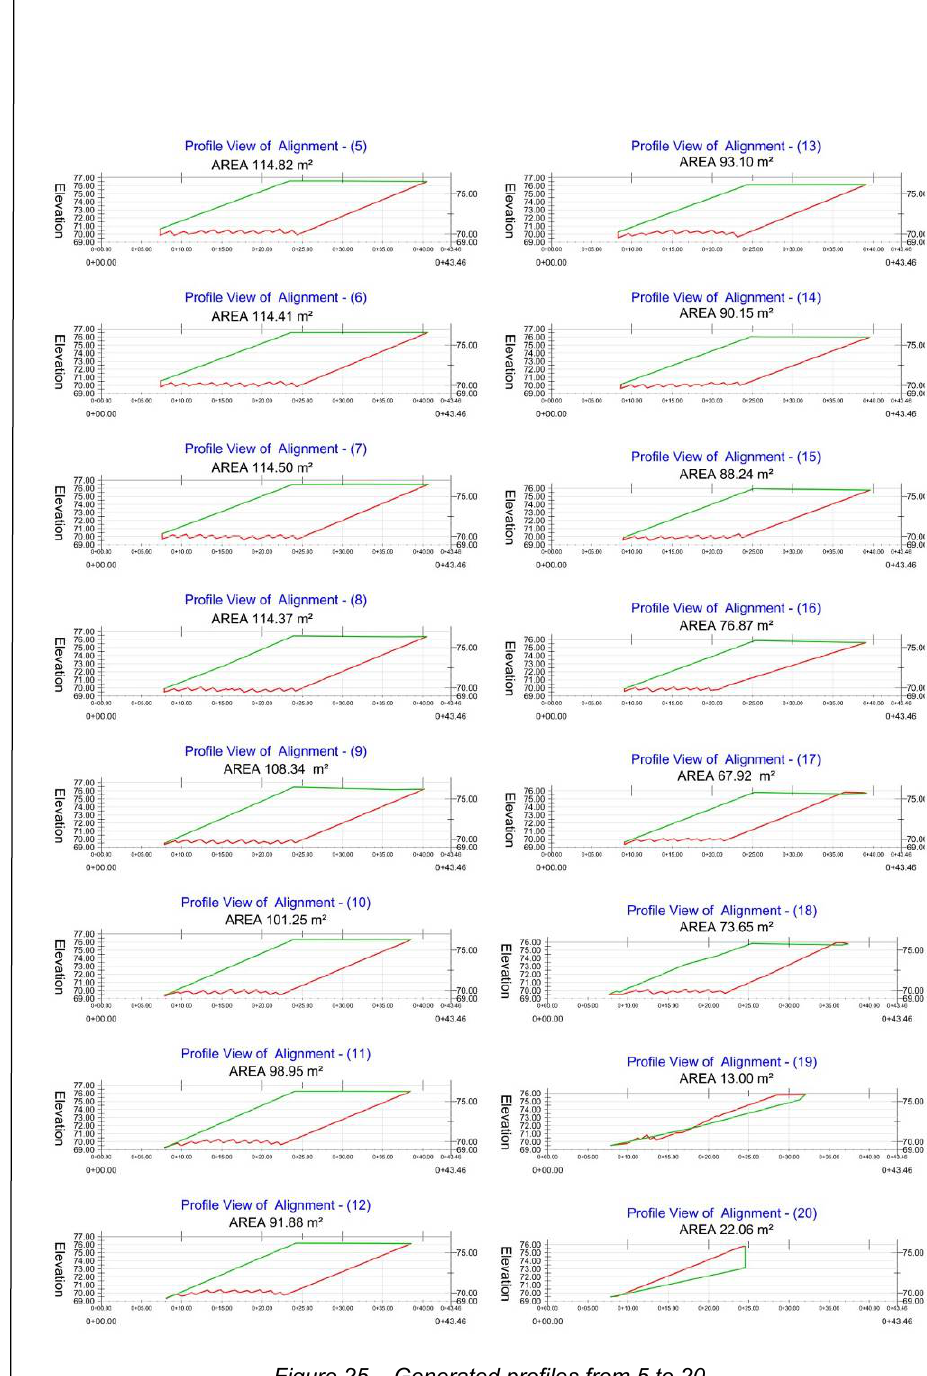
Figure 25 – Generated profiles from 5 to 20 Рис . 25 – Сгенерированные профили с 5 до 20 Слика 25 – Генерисани профили од 5 до